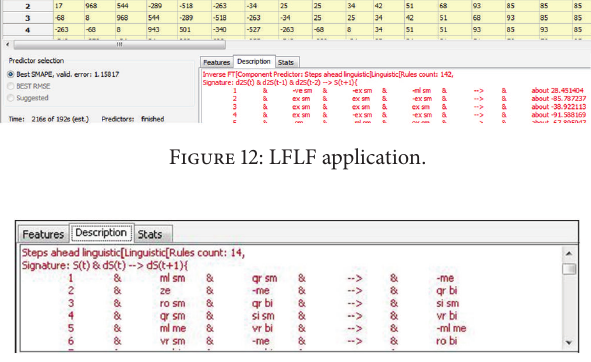
Figure 13: Winning predictor linguistic description (trend-cycle